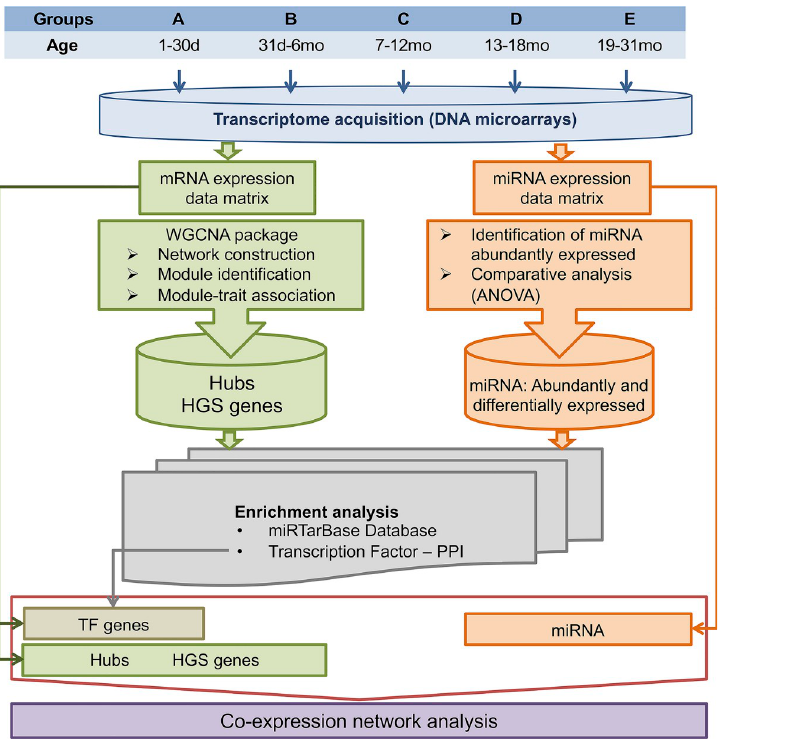
Fig 1. Workflow of the experimental approach and overview of the bioinformatic analyses.